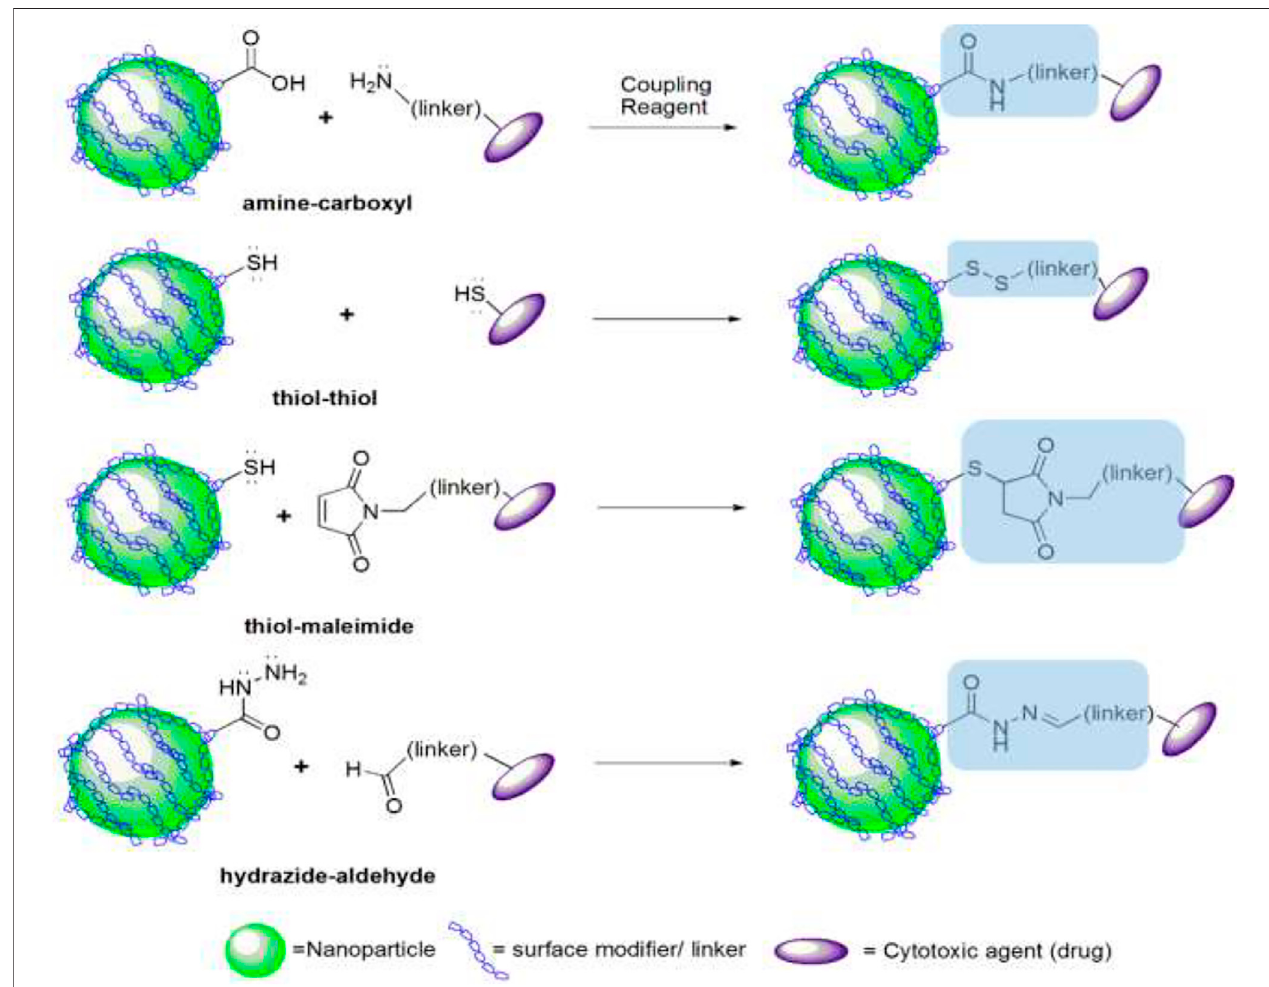
FIGURE 4 | Strategies of conjugation for DDS based on the modi fi ed nanoparticle surface.